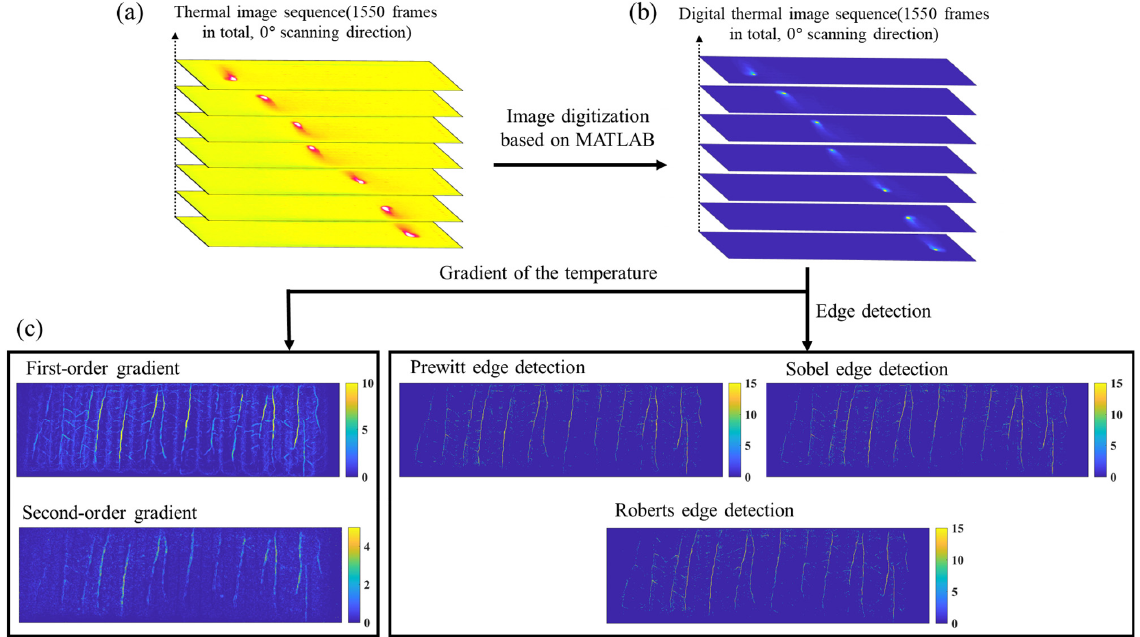
Figure 13. Detailed processing workflow for thermal images: ( a ) Thermal images acquired by an infrared camera; ( b ) Digital thermal image sequence converted by MATLAB; ( c ) Post-processing results of digital thermal image sequence.